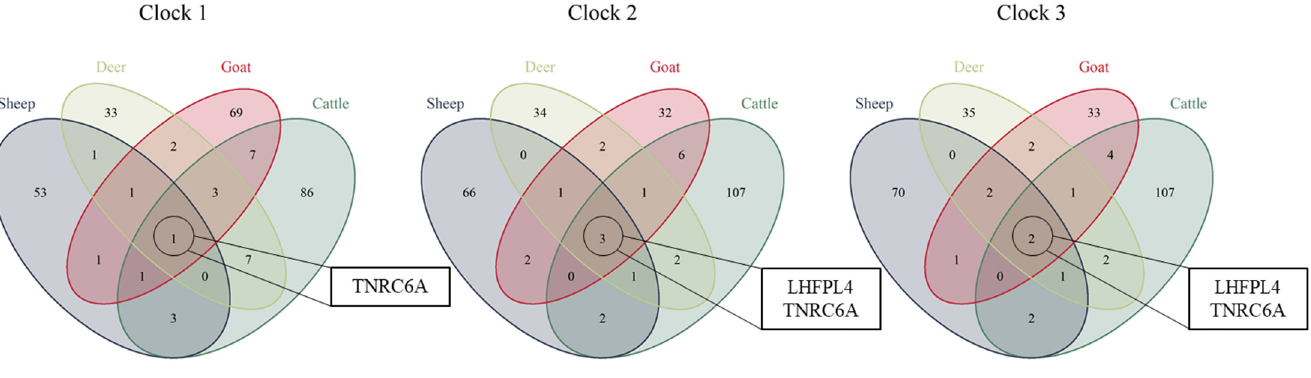
Figure 4. Venn diagrams depicting the overlap of CpG sites included in each of the individual species’ clocks for clock 1, clock 2 and clock 3. The CpG sites common across all four species lie within the genes TNRC6A and LHFPL4 .